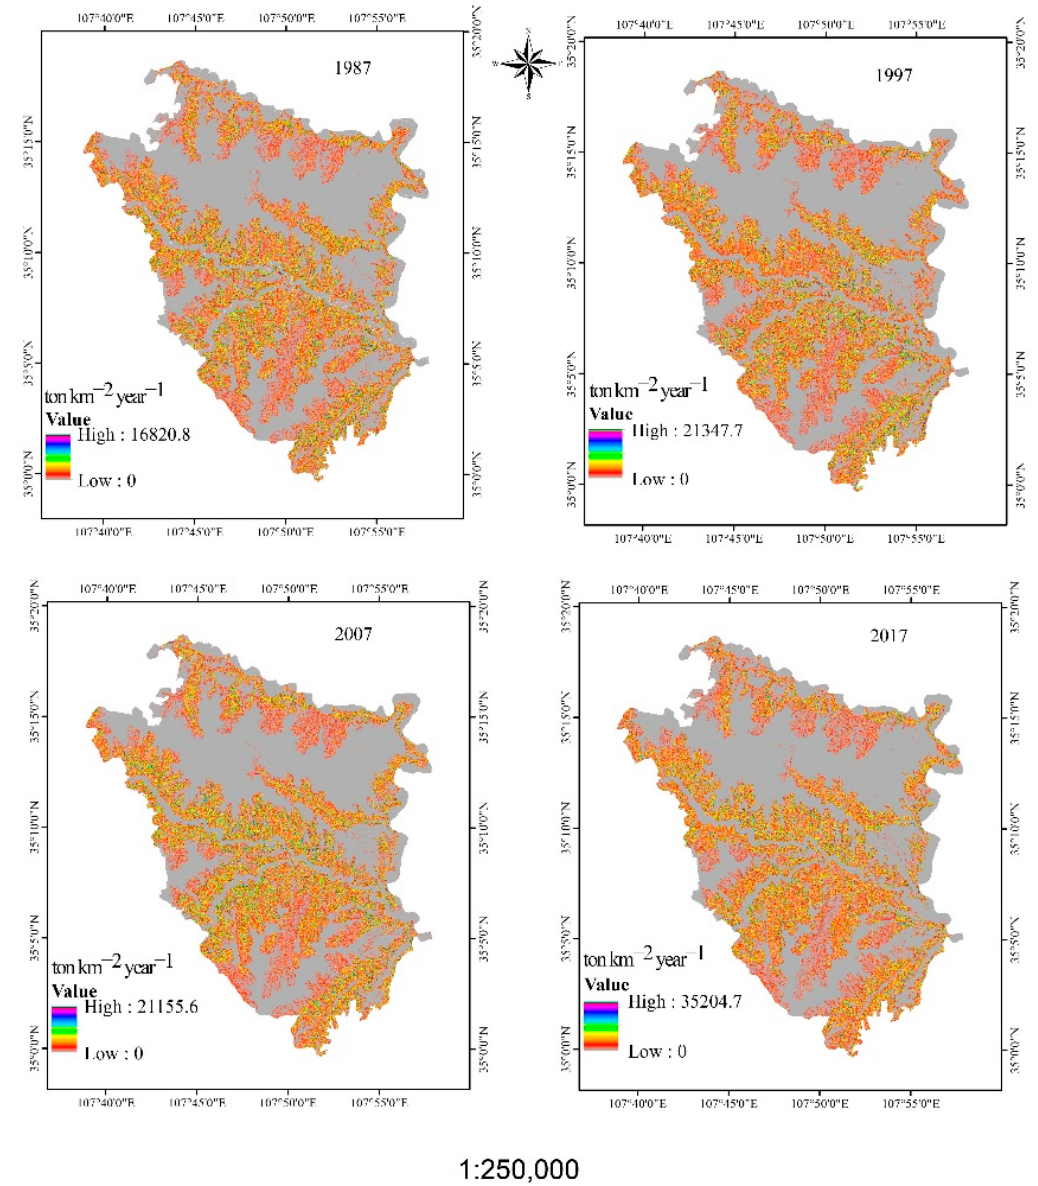
Figure 4. The soil erosion intensity maps for 1987, 1997, 2007 and 2017.